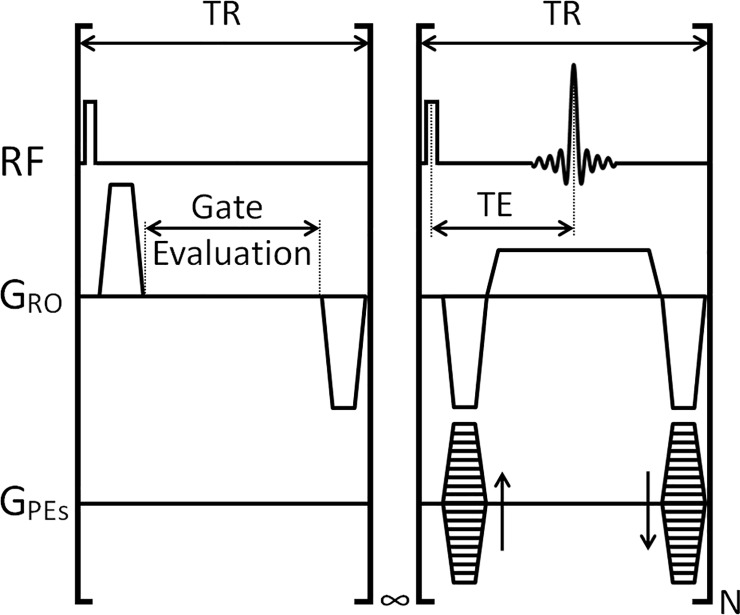
Pulse sequence schematic for the CR-synchronised bSSFP scan.The scan operates with 2 sections; in the first section the scan delivers RF and gradient pulses whilst evaluating the state of a 0 or 5-volt control signal. Upon receipt of the 5 V control signal, which is generated only from interbreath R-waves, the infinite loop is terminated and the second section, a block of N k space lines (32 in this case) were acquired before the scan reverted to the first section. Throughout the scan the steady state magnetisation was kept constant through the use of constant TR. Where a breath was identified, by a counter exceeding a time period equal to ca. 250 ms, longer than 2 heartbeats but shorter than a breath motion, then data from the 2 r-waves preceding the breath were reacquired immediately after the end of the same breath. This modus operando gives a very good desensitisation to both cardiac and respiratory motions. TR: repetition time; TE: echo time; RF: radiofrequency pulse and acquire channels; GRO: Readout gradient; GPEs: Phase-encoding gradients; N: number of phase-encoding lines per R-wave.